Question: In a single sentence, describe what this figure presents.
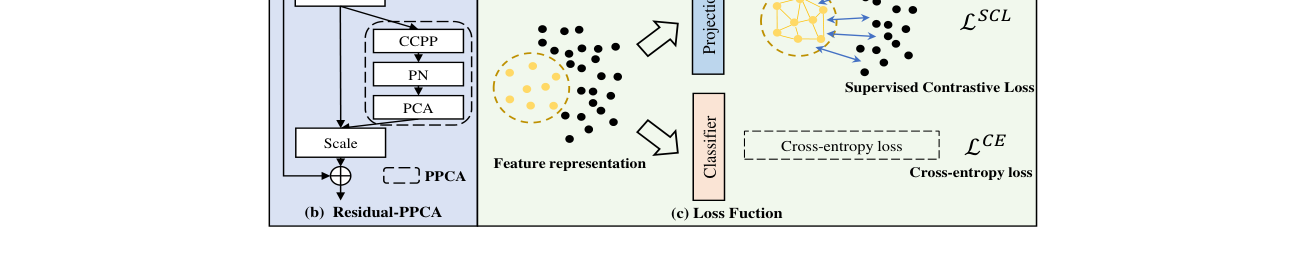
Answer: (a) provides the general framework of pyramid pixel context adaption network (PPCANet) for medical image clas- sification by taking ResNet as the backbone. In the PPCANet, we combine the PPCA module with the residual module to construct a Residual-PPCA module. Our PPCANet takes a medical image as the input, and a convolutional layer is applied to produce low-level feature representations. Next, a sequence of Residual-PPCA modules generate high-level fea- ture representations. Finally, a global average pooling (GAP) and the softmax function are utilized to generate the predicting label of each input medical image. Furthermore, we not only adopt the classical cross-entropy (CE) loss as the loss function but also take supervised contrastive loss as the auxiliary loss to exploit label information from the contrastive pair perspective (as presented in Fig. 4(c)), which will be introduced in the following section.